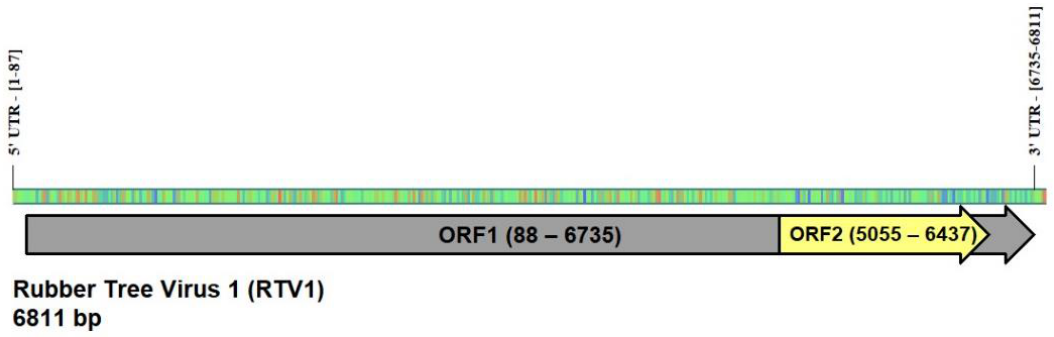
Figure 2. Schematic representation of the RTV1 genome. Coordinates are designed based on accession number of the RTV1